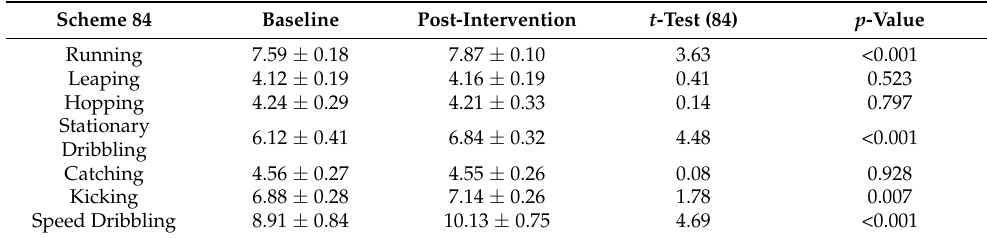
Table 1. Descriptive (mean ± 95% confidence interval) and inferential statistics ( t -test) of running, leaping, hopping, stationary dribbling, catching, kicking, and speed dribbling in the first and second data